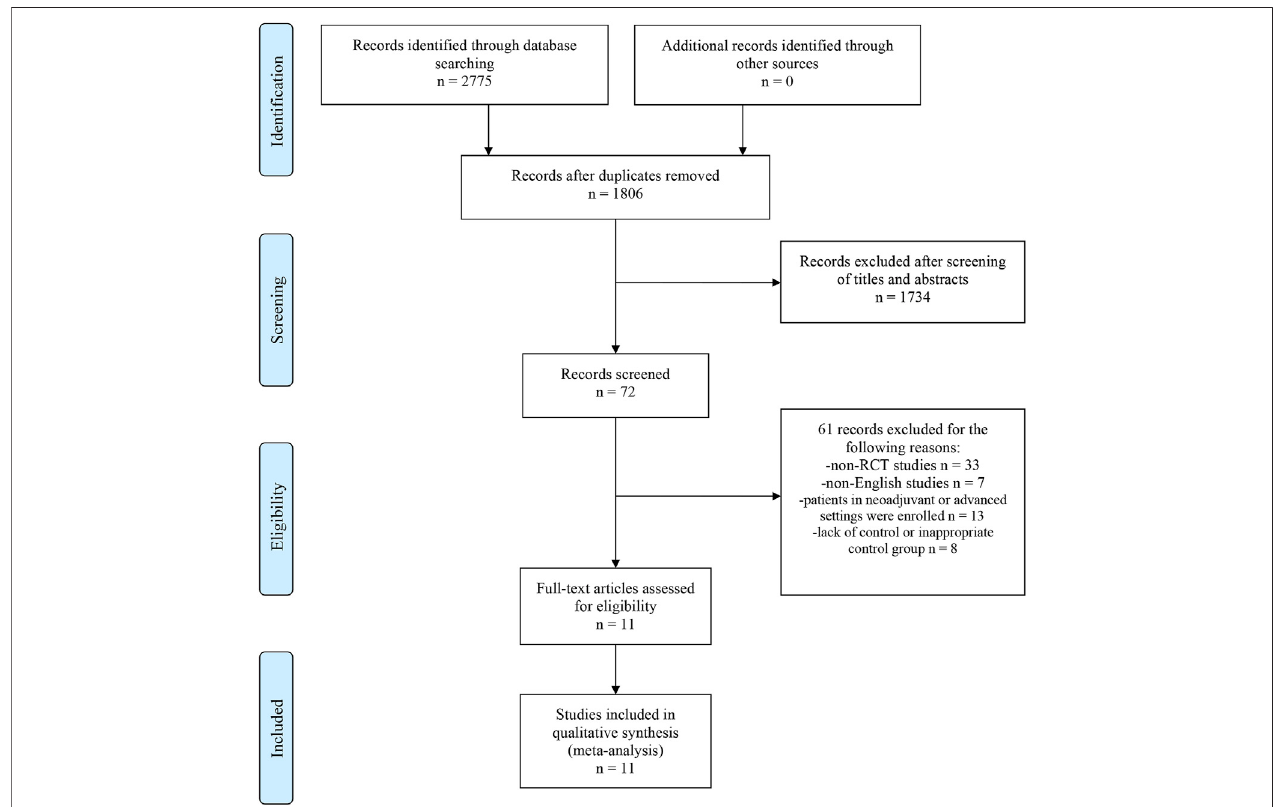
FIGURE 1 | Flow Diagram of study selection process. Abbreviations: PRISMA, Preferred Reporting Items for Systematic Reviews and Meta-Analysis; RCT, randomized controlled trial.